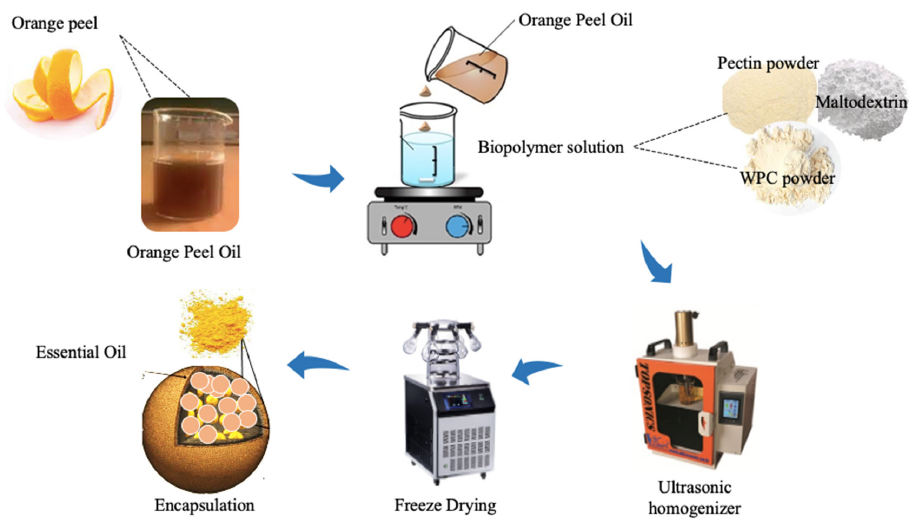
Figure 1. Encapsulation process of orange peel oil.